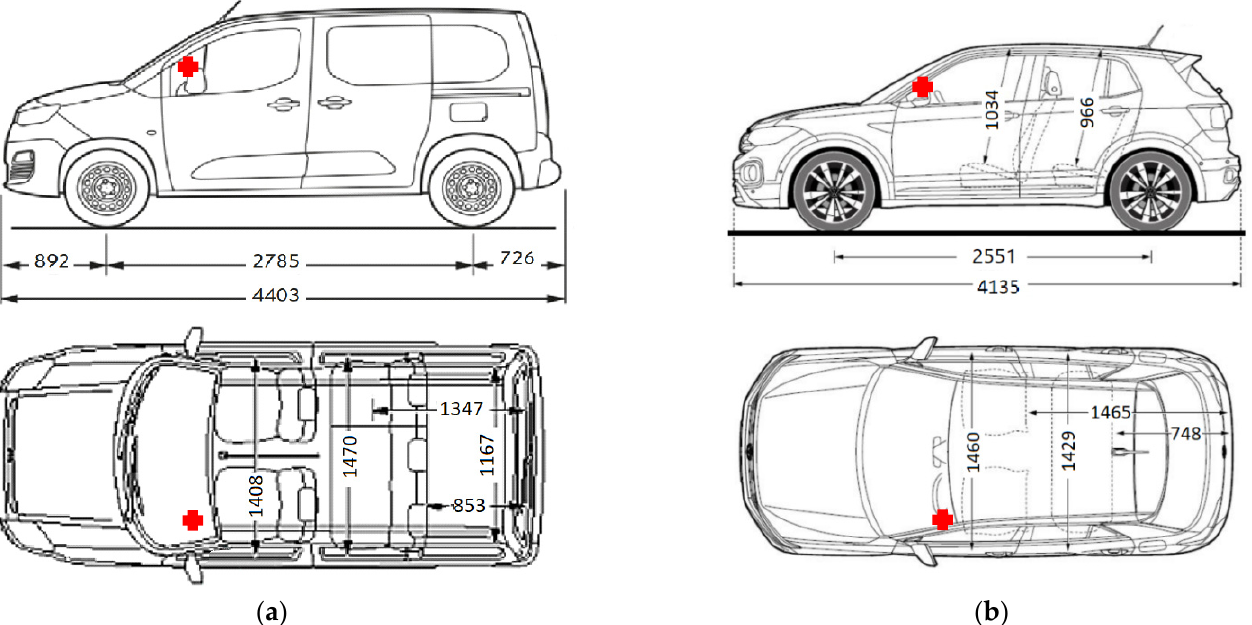
Figure 11. Experimental setup: measurement point (red cross) inside the car ( a ) CAR A, and ( b ) CAR B.